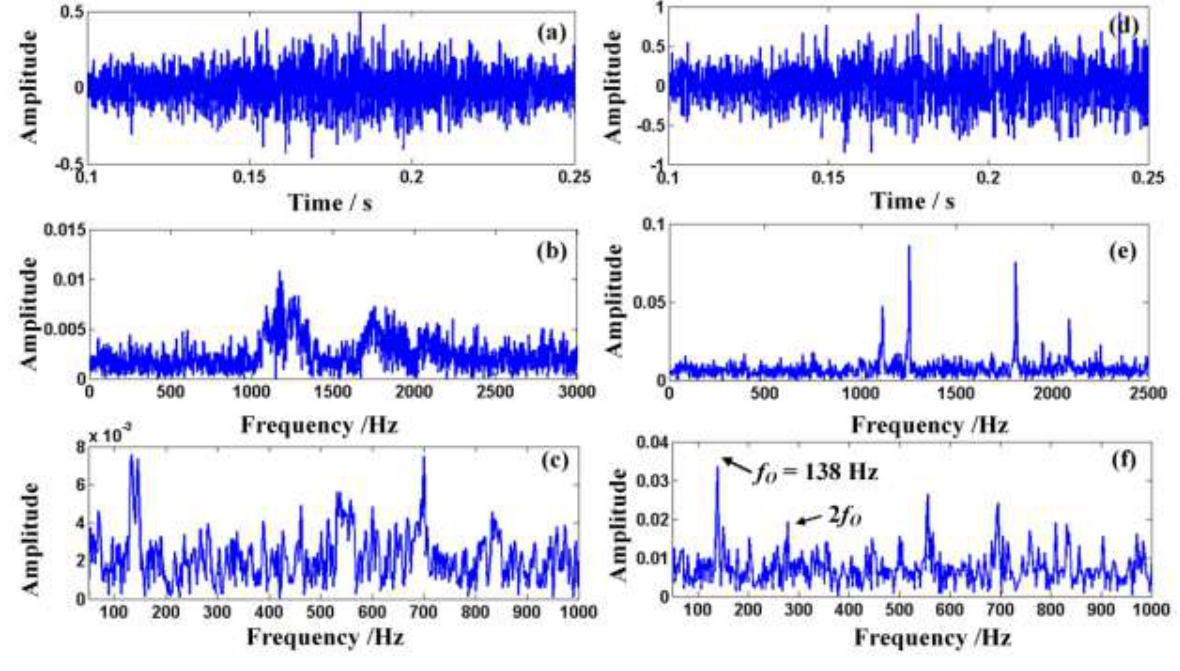
Figure 13. ( a – c ) The waveform, the spectrum and the envelope spectrum of the Doppler distorted signal emitted by the fault bearing with a outer-race defect; ( d – f ) the waveform, the spectrum and the envelope spectrum of the restored